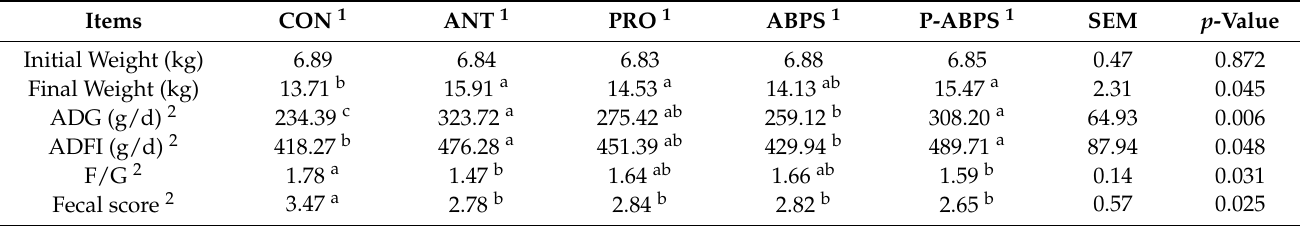
Table 2. Effects of probiotics and achyranthes bidentata polysaccharides on the growth performance of piglets (23–51 d).